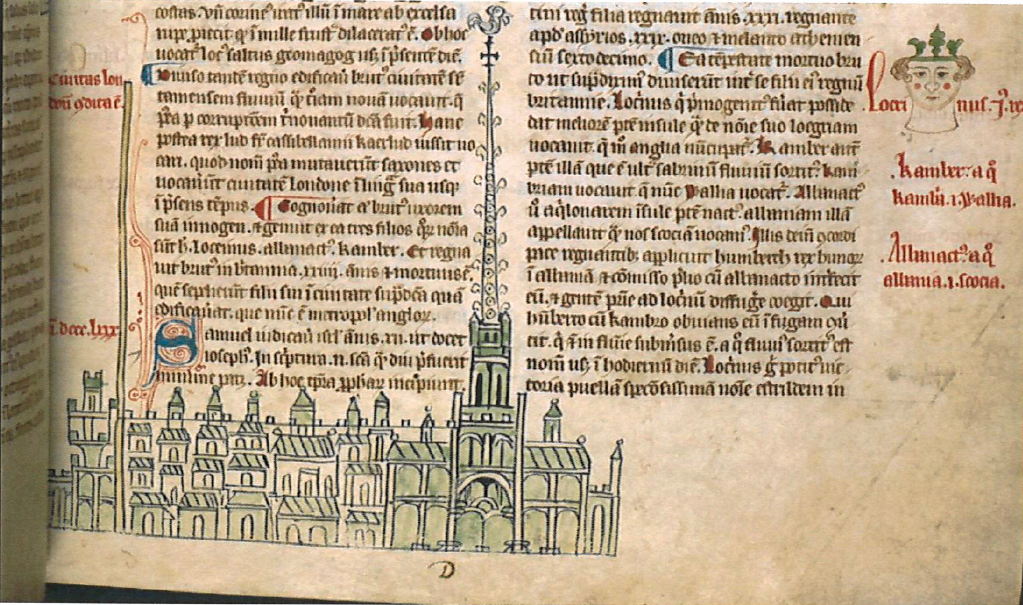
Fig. 8. Elevation of St. Paul’s Cathedral, c. early fourteenth century. London, British Library, Cotton MS. Nero D. II, f.